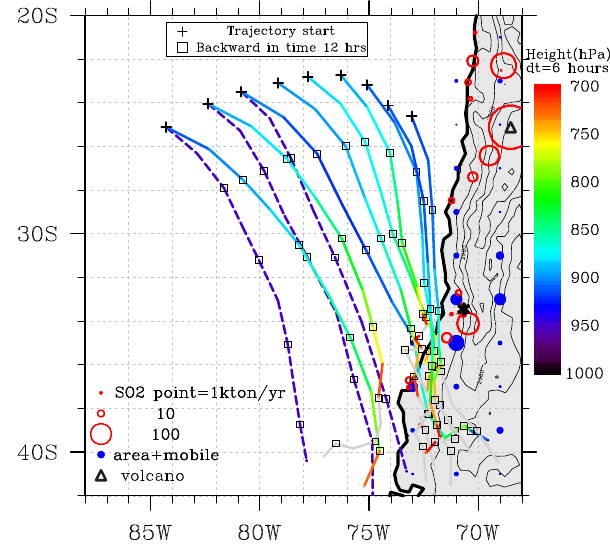
Fig. 3. ECMWF 3-D back trajectories initialized from 2-D hook MBL trajectory points on 18 October at 12:00UTC (Fig. 2), but at the inversion level (the ECMWF level at which temperature is a minimum for relative humidity larger than 50%) rather than 950hPa. Colors represent trajectory heights in hPa, gray indicating heights above 700hPa. Squares mark 12h time intervals. Dashed lines show a few 950hPa MBL 2-D trajectories from Fig. 2. Land contours are elevation height in 1000m resolution and the “*” marks Santiago. SO 2 emissions from anthropogenic and volcanic sources are shown with open red circles for point sources (including smelters and volcanos) and blue filled circles demonstrating 2 ◦ × 2 ◦ average area+mobile urban and industrial